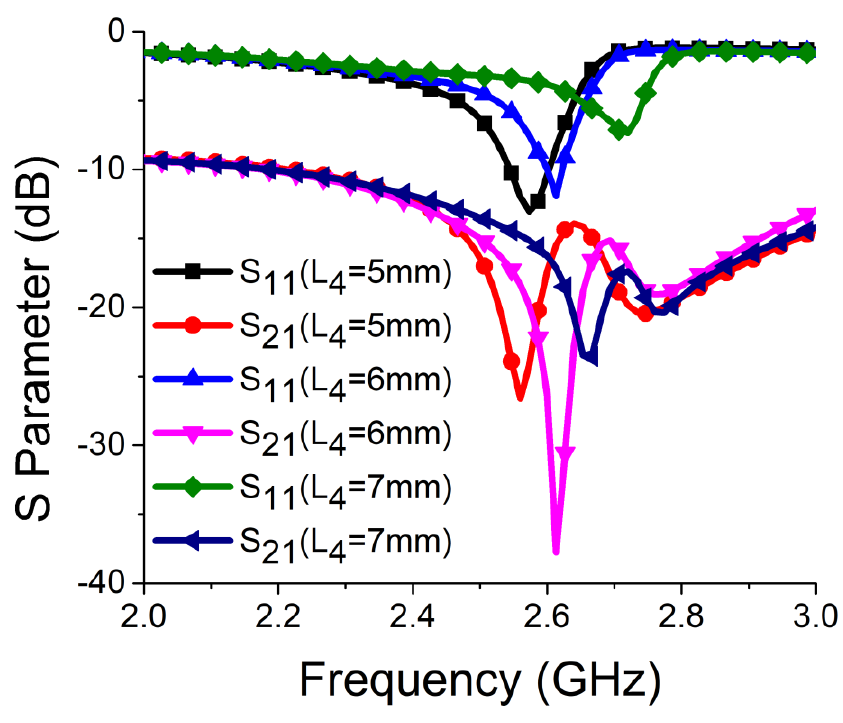
Figure 10. Effect of L 4 on resonance and isolation.